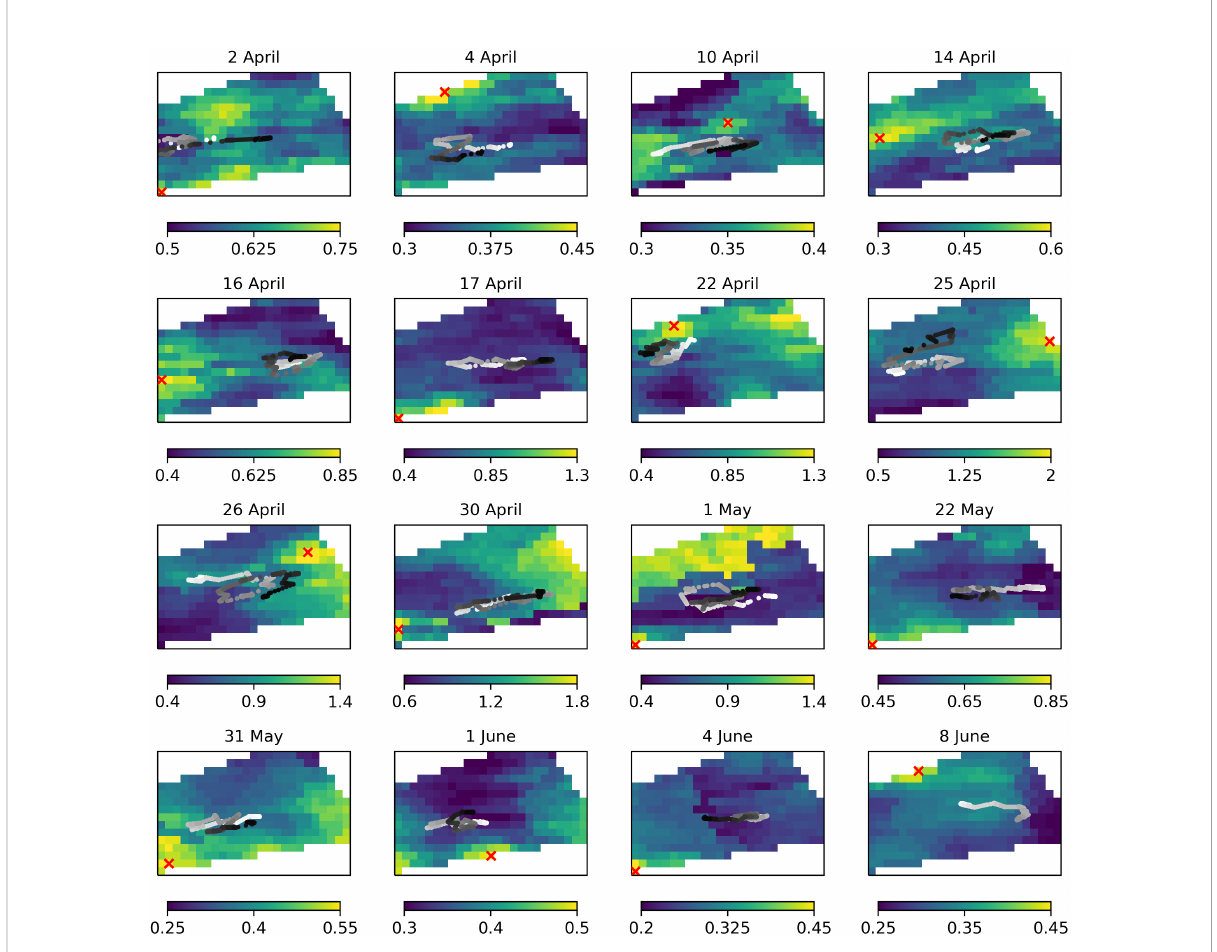
FIGURE 10 For each day with complete ocean color coverage, maps of chl- a (mg m -3 ) from ocean color overlaid with the glider positions that day (grey dots, getting darker from white to black between 00:00 and 23:59) and position of maximum chl- a estimated from ocean color (red